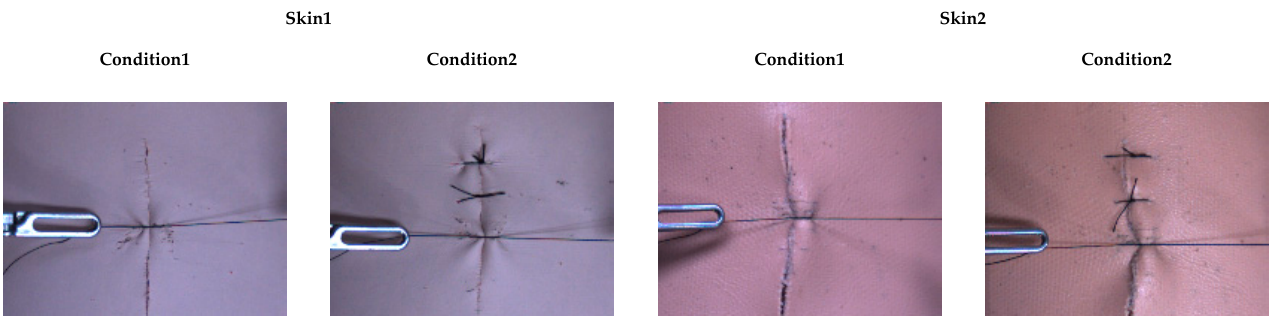
Figure 3. Two soft objects and two conditions per soft object used for experiment. Two artificial skin types with different elastic modulus: the elastic modulus of Skin1 is 387.23 kPa, and the elastic modulus of Skin2 is 68.26 kPa. Each artificial skin has two different conditions. Condition1 represents the start of the suture process. Condition2 represents an intermediate stage during the suture process.